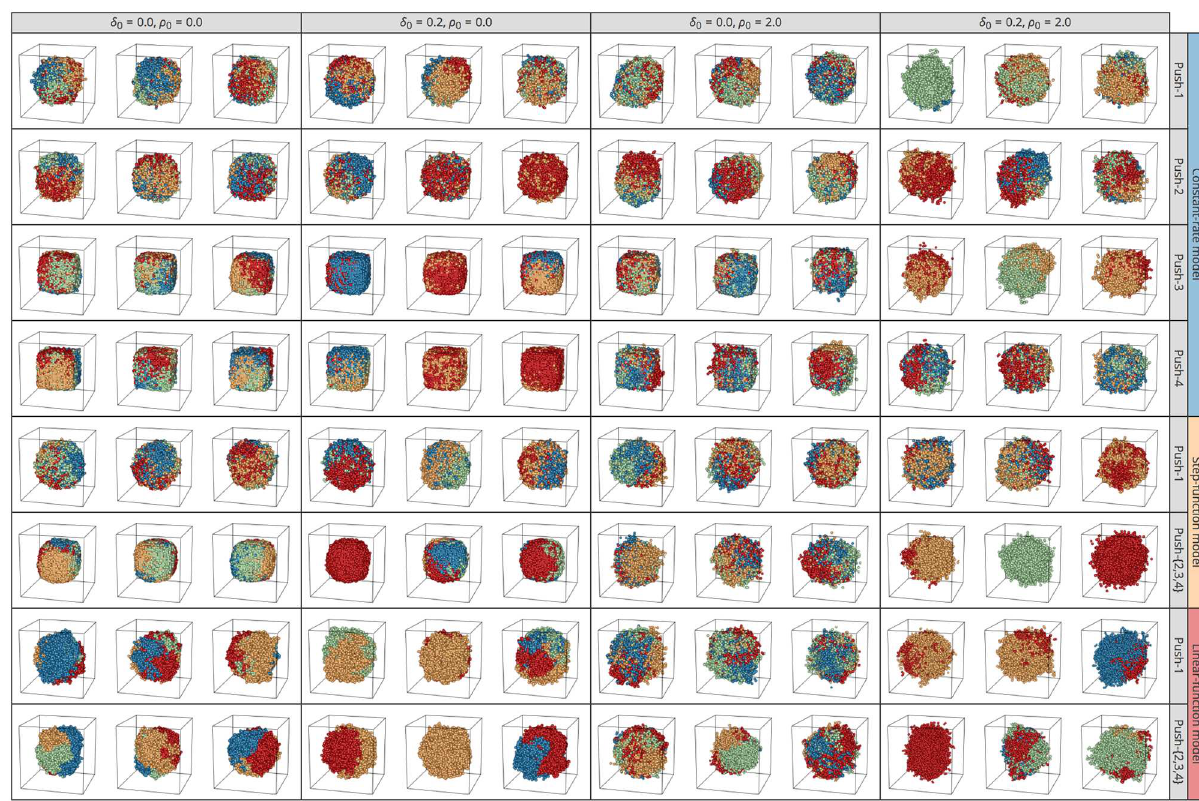
Fig 10. Effect of cell death and migration on the 3D structuresof simulated tumors for push methods 1–4 under constant-rate, step-function, and linear-function models. k = 1 is assumed. Descendants of the first four cells in each simulationrun are presented in blue, green, yellow, and red. The results of three independent runs are shown for each setting.